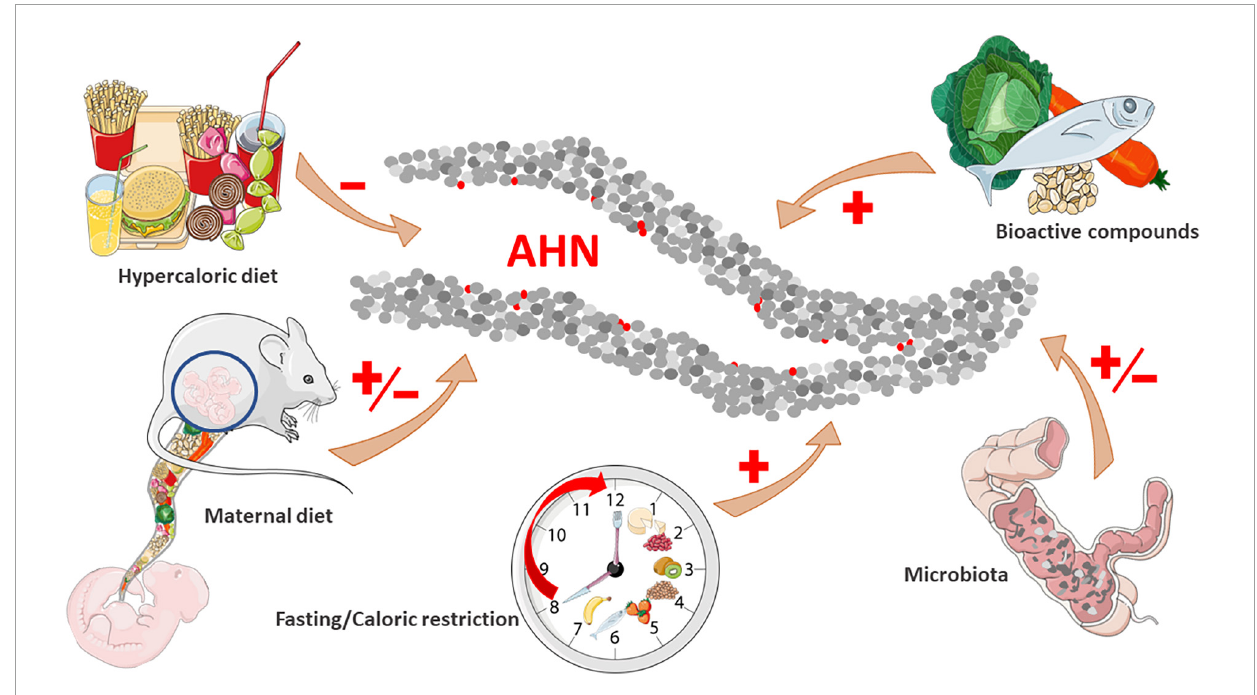
FIGURE1 Impact of nutrition on adult hippocampal